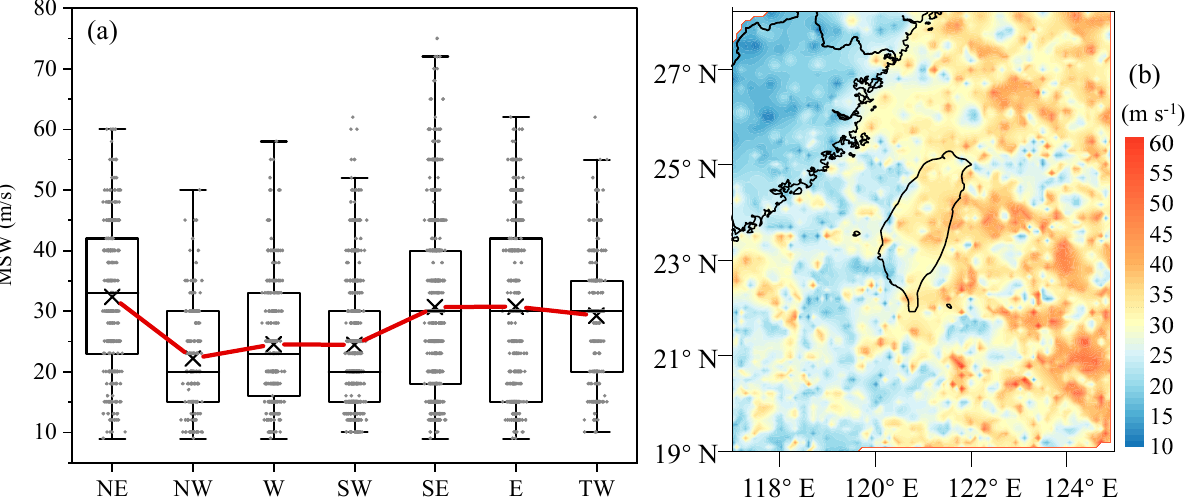
Figure 5. ( a ) Box plot of MSW (unit: m s − 1 ) in subregions (black crosses and the red line indicate the mean value for each subregion) and ( b ) spatial distribution of the MSW near Taiwan Island from 1979 to 2021 (unit: m s − 1